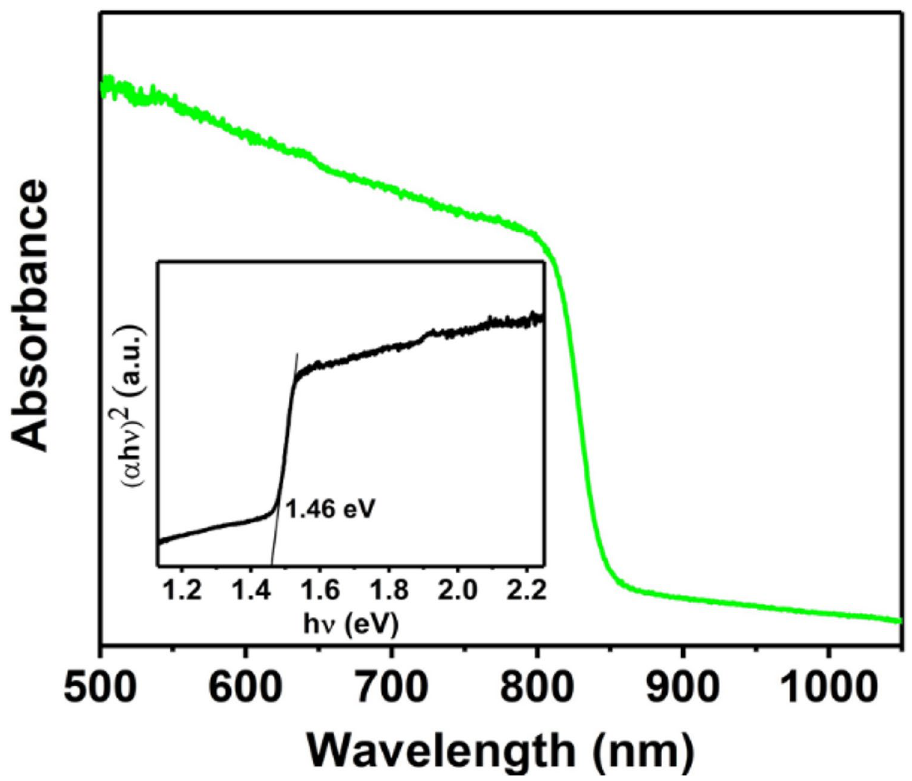
Figure 3. Optical absorbance spectrum of a FAPI thin film deposited by AACVD on a glass substrate at 150 °C. Inset: Tauc plot of FAPI thin film showing an estimated direct optical bandgap of 1.46 eV.